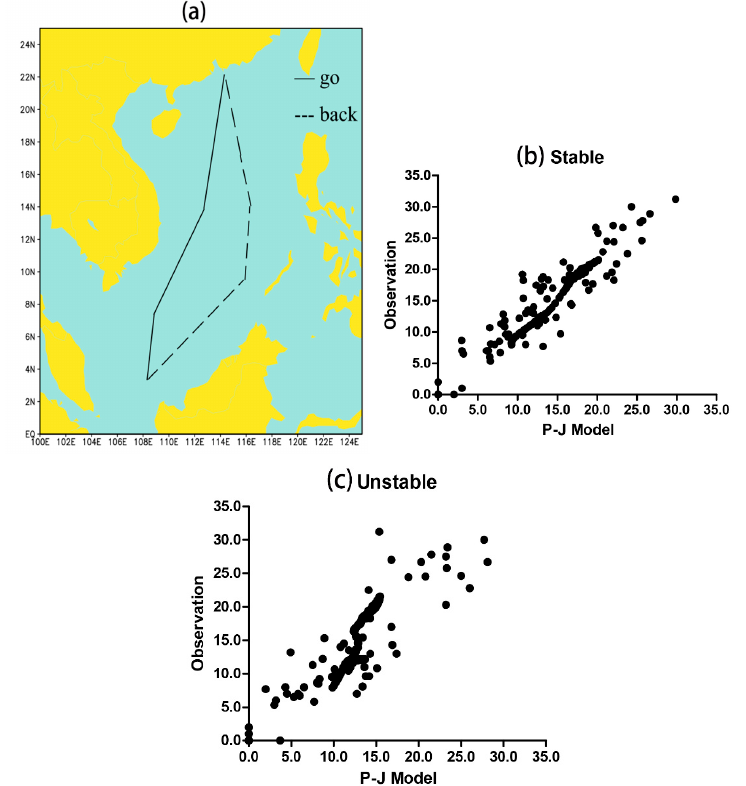
Figure 2. Accuracy test for the 2.3. Paulus-Jeske (P-J) model over the South China Sea (SCS) region during summer: ( a ) the voyage route of the Chinese Navy ships in summer 2016; ( b , c ) comparison of P-J models and observed duct height in ( b ) stable and ( c ) unstable atmospheric conditions.